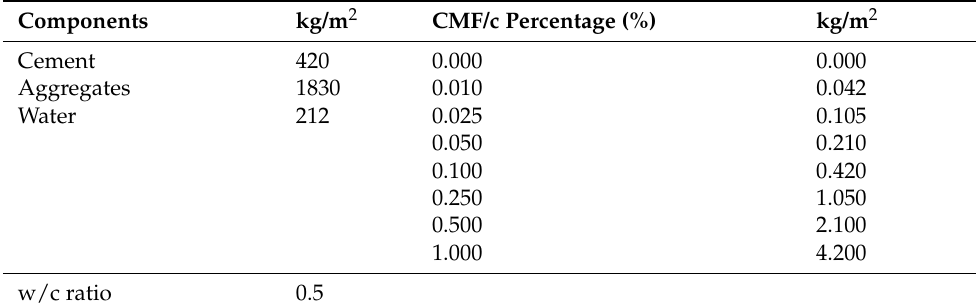
Table 1. Mix design for smart concrete.